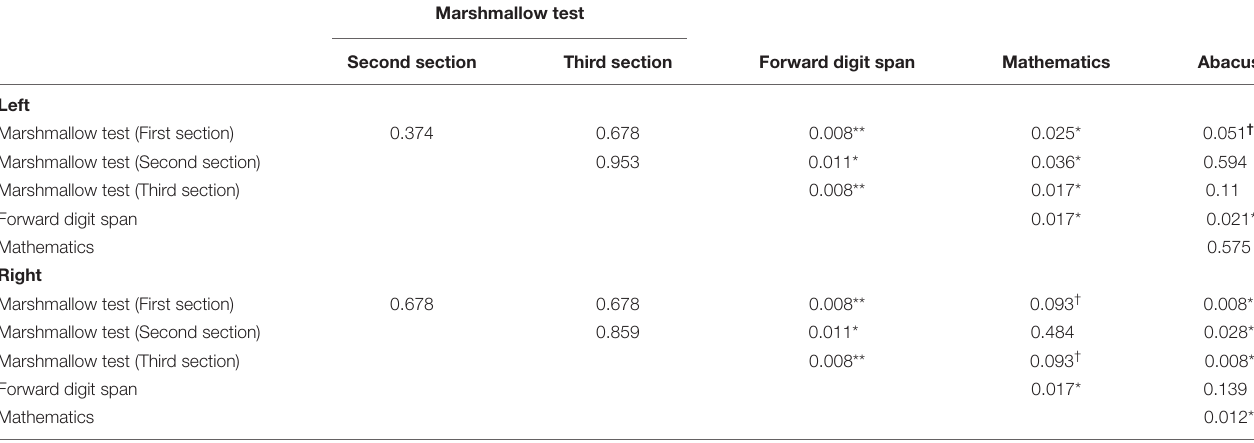
TABLE 2 | The p -values for each task of the Wilcoxon signed-rank